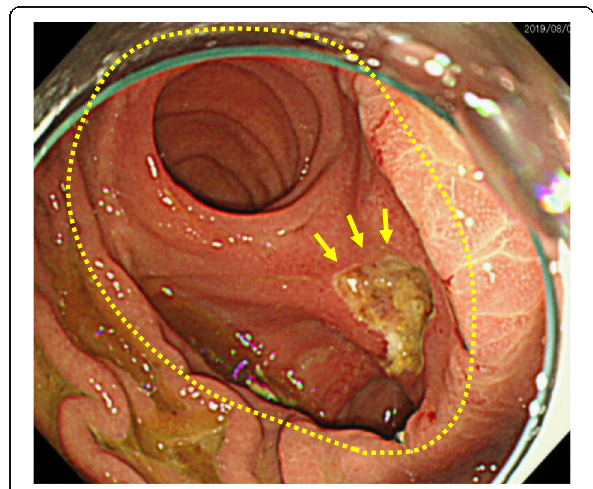
Fig. 5 Findings of endoscopy 3years after surgery. Anastomotic ulcer (yellow arrow) at the gastrojejunostomy (yellow circle) was found